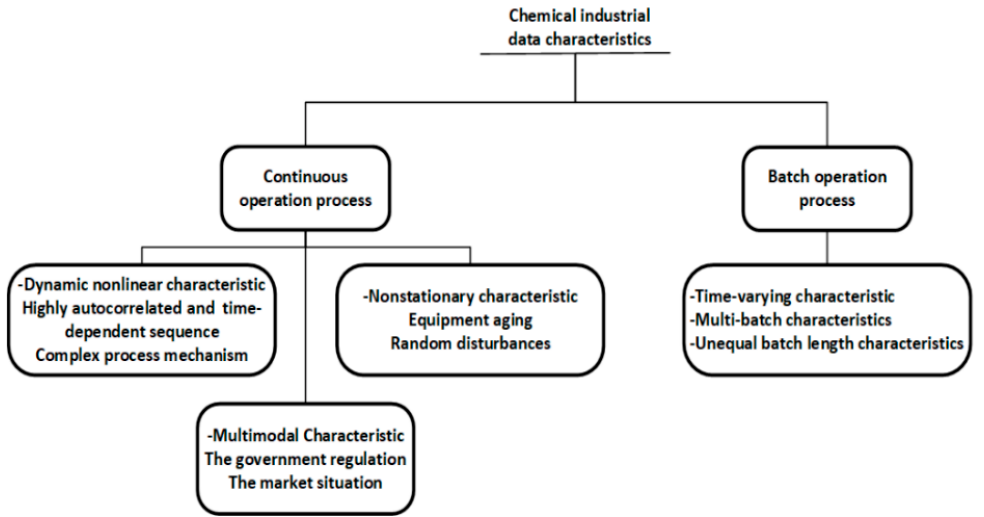
Figure 2. The characteristics of data from the chemical process industry.